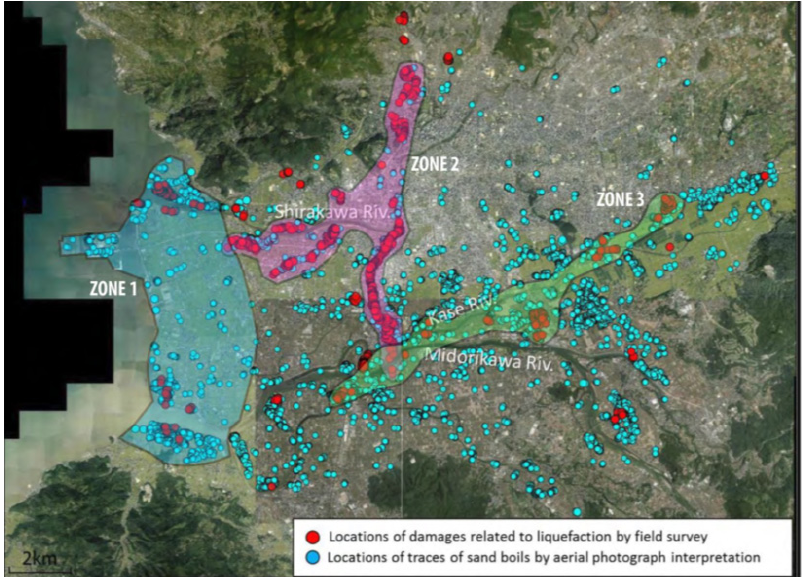
Figure 7. Locations of suspected liquefaction from aerial photographs (shown in blue) and of confirmed liquefaction from field surveys (shown in red); altered from Mukunoki et al. [17] by Anderson [40].